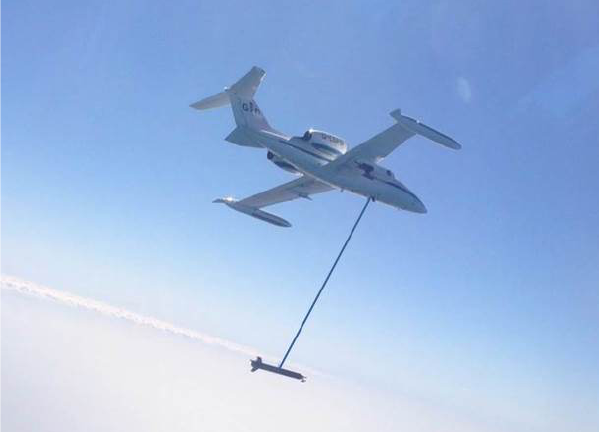
Figure 1. Photo from the Learjet 35A with towed AIRcraft TOwed Sensor Shuttle. The picture was taken during a test flight from a sec- ond aircraft. The cable was artificially thickened to make it visible in the